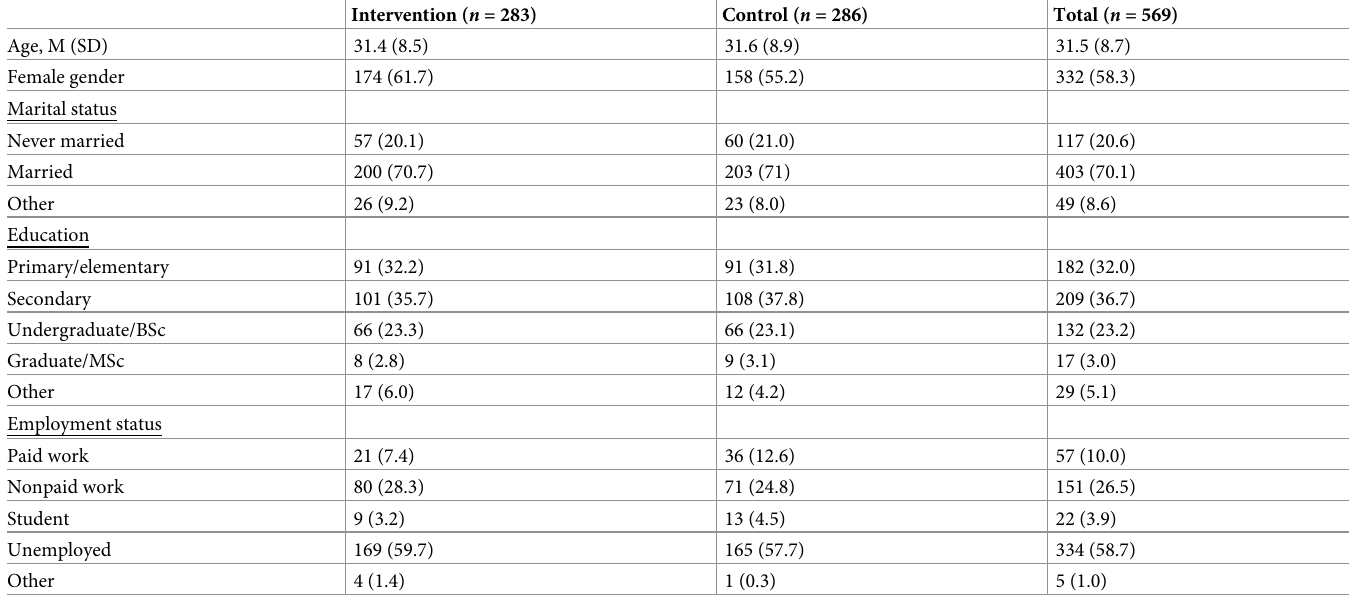
Table 1. Demographic and baseline characteristics a .